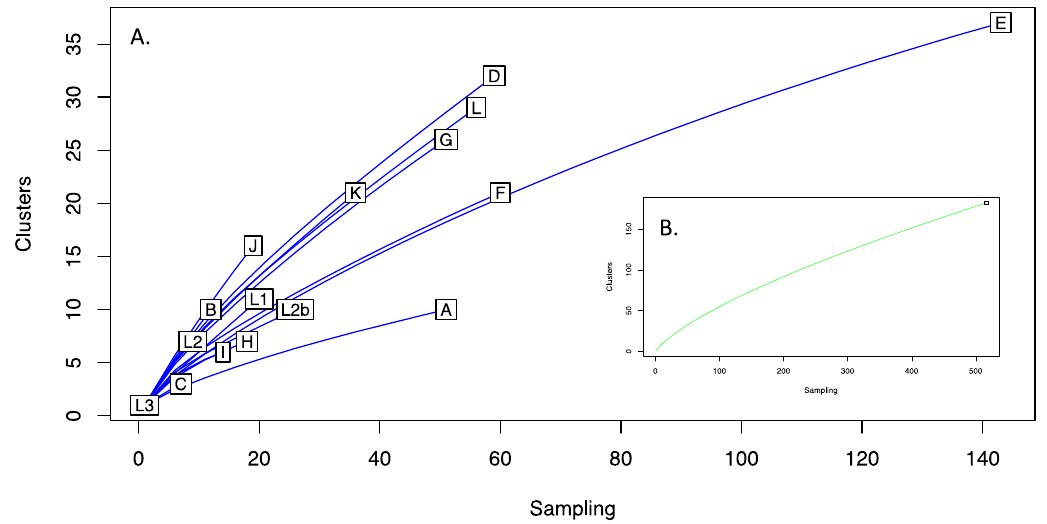
Figure 2. Rarefaction of C. trachomatis plasmid nucleotide sequences. Aligned sequences were clustered using cd-hit-est at 100% nucleotide identity. The diversity of each lineage, as measured by cluster discovery versus sampling effort (rarefaction), is shown for each plasmid lineage ( A ) and all sequences (inset ( B )). No asymptotes were observed indicating sampling e ff ort had not captured all the diversity within the C. trachomatis plasmid populations. Lineages A and C were the least diverse (L3 being represented by only one sequence), with D and J the most diverse.